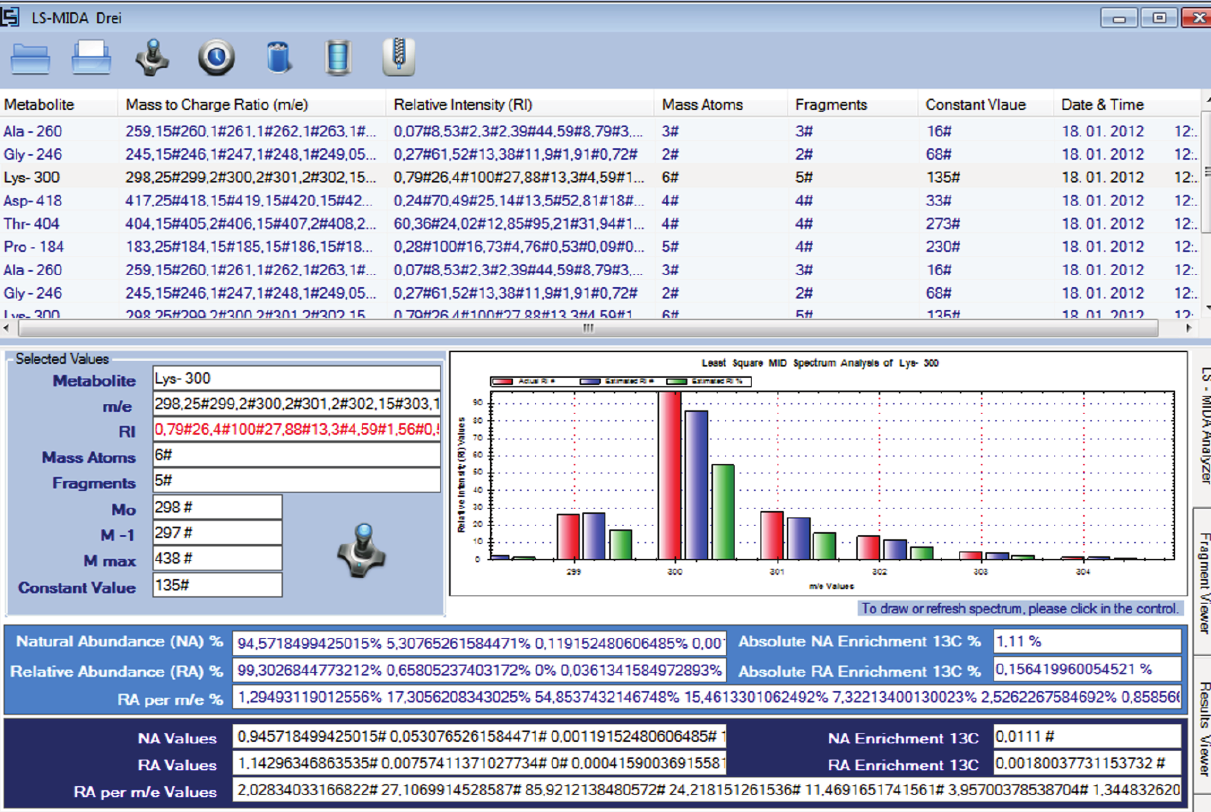
Figure 9. Least Square Mass Isotopomers Distribution Analysis’s (LS-MIDA) main graphical user interface. Scientific software solution towards bioinformatics and biochemistry which estimates mass isotopomers distribution from spectral data by analyzing each peak of given mass and each mass atom fragment.